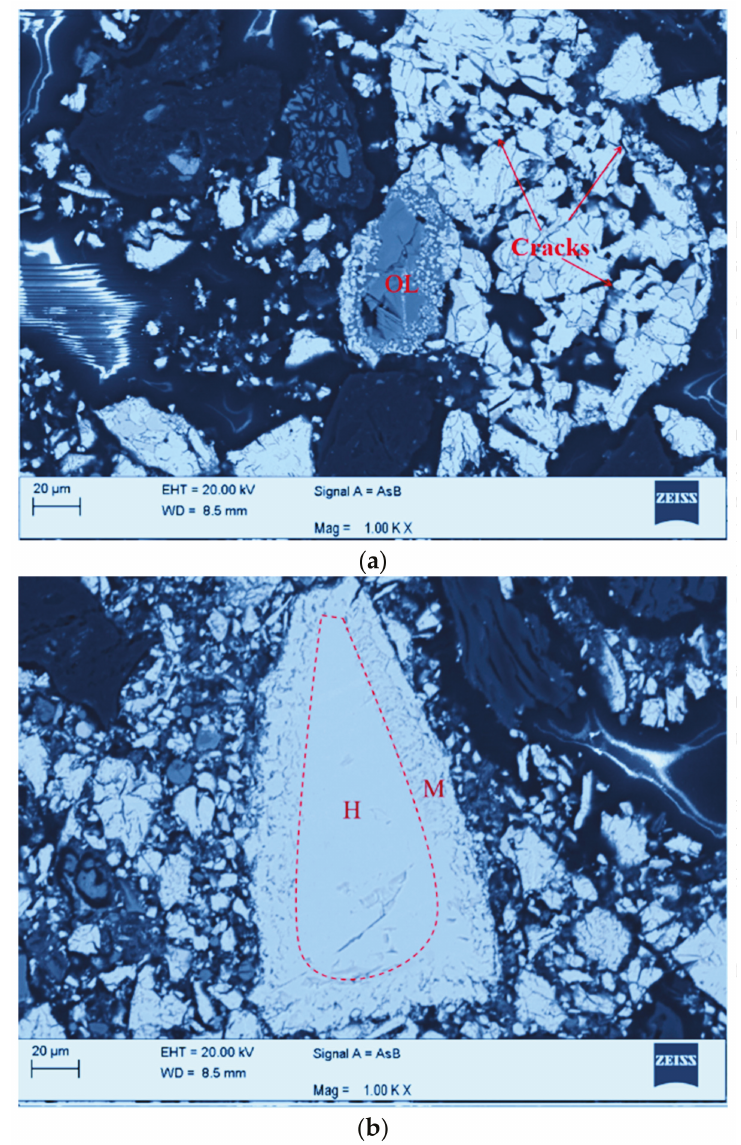
Figure 7. SEM image (magnification 1000 × ), of composites from tests, interrupted at 740 ◦ C. ( a ) SDC, ( b ) HTTC, H = hematite, M = magnetite, and Ol =